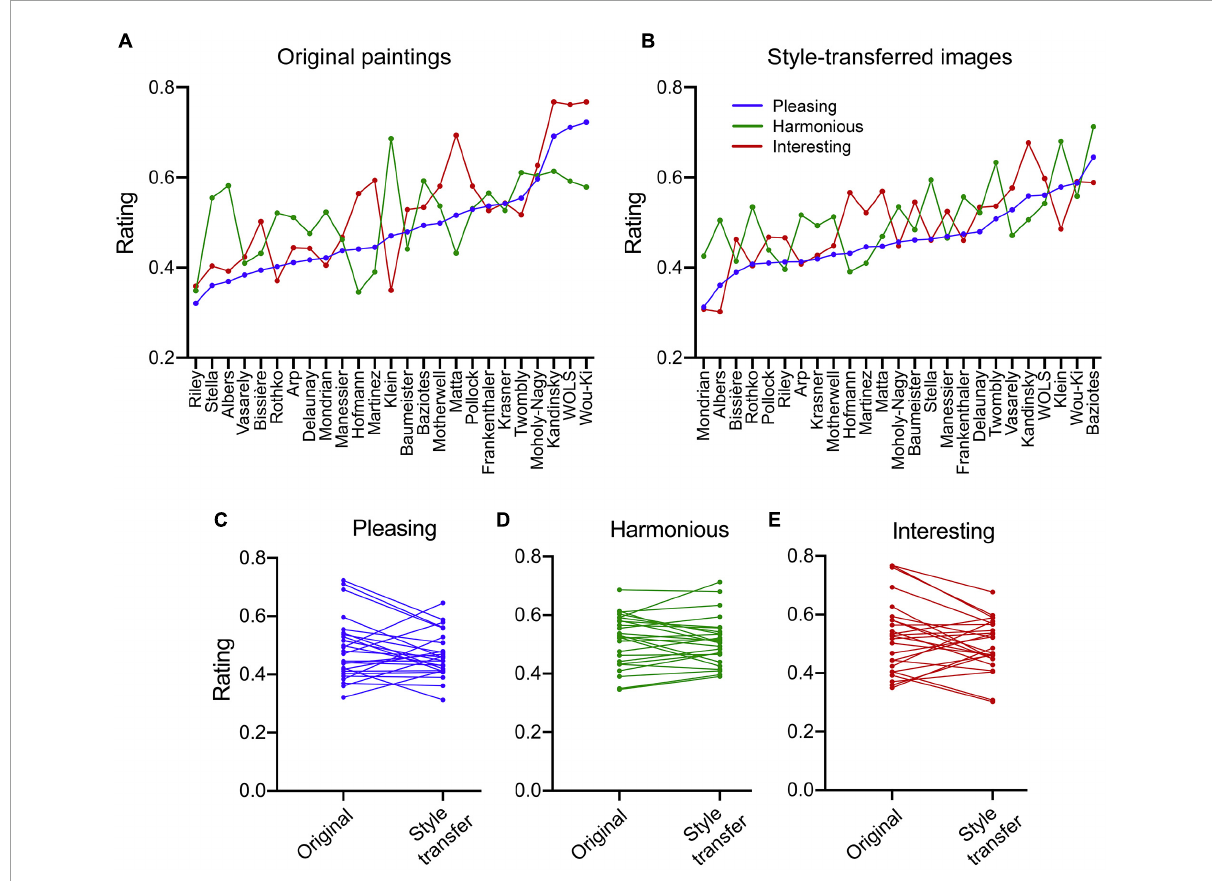
FIGURE5 Mean rating responses of participants for the original paintings (A) and for their style-transferred counterparts (B) . Ratings are shown for Pleasing ( blue ), Harmonious ( green ) and Interesting ( red ). In both panels, individual artists are ordered from left to right in a sequence of ascending Pleasing responses. Spearman’s coefficients ( ρ ) for the correlations are listed in Table 3 . (C–E) Same data as shown in (A,B) but plotted in slope graphs, separately for the different rating dimensions. Each line connects the mean rating responses for an original painting of one artist and for its style-transferred